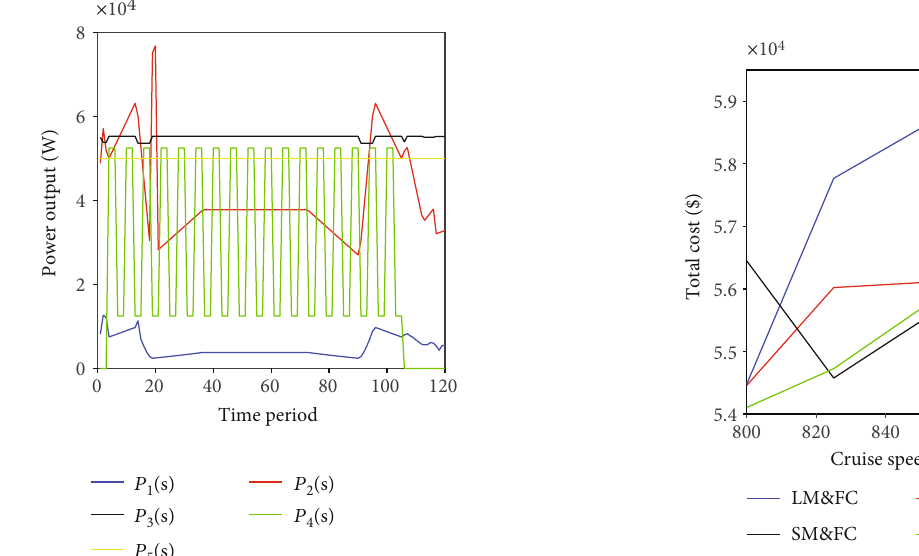
Figure 8: Total cost analysis under di ff erent combinations of cruise altitude and speed with standard aircraft mass and gravity center position.